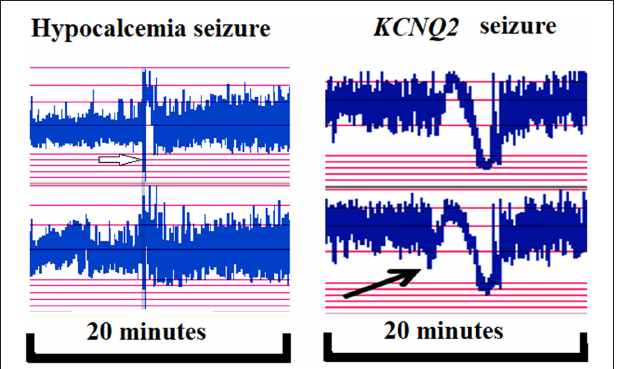
FIGURE 5 | In hypocalcemic (left, white arrow) and KCNQ2 (right, black arrow) seizures, the ictal seizures on automated electroencephalography (aEEG) displayed a stereotypical triphasic pattern in aEEG, which was first downflected of the aEEG background, then upflected and then